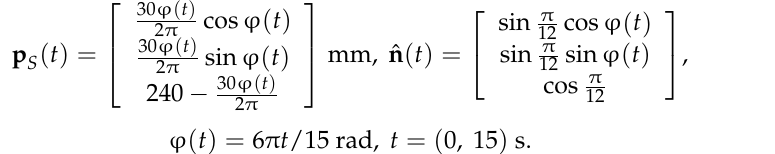
Figure 6. Results of velocity analysis: blue lines— 𝐪 ; red lines— 𝐪(cid:4662) according to the proposed algorithm; green dots— 𝐪(cid:4662) by numerical differentiation of 𝐪 .